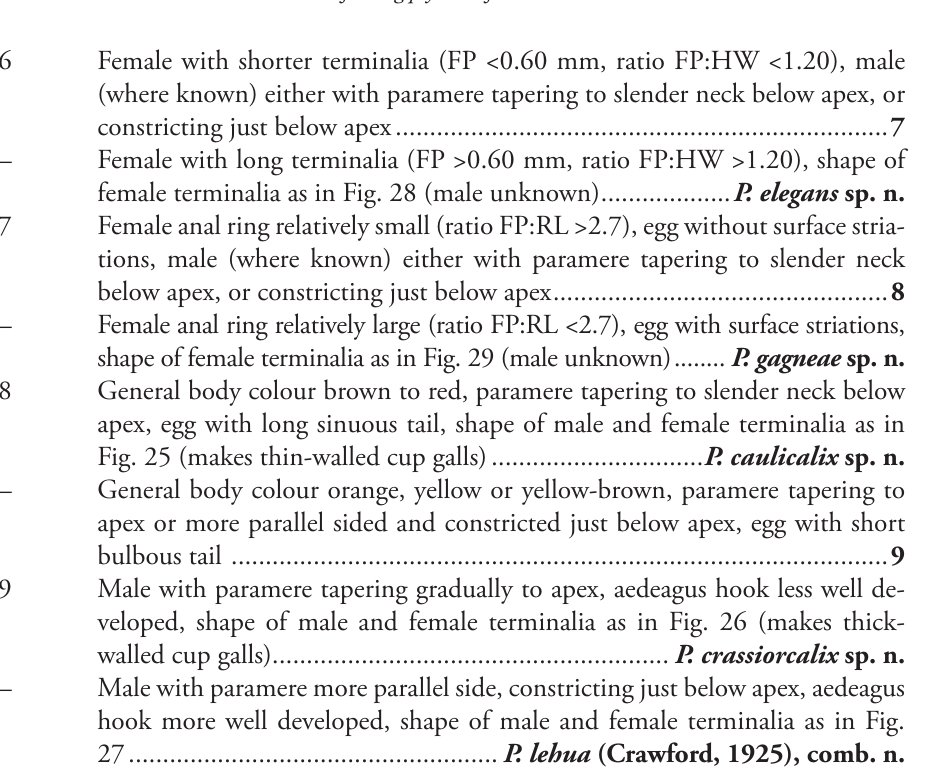
Female with shorter terminalia (FP <0.60 mm, ratio FP:HW <1.20), male (where known) either with paramere tapering to slender neck below apex, or constricting just below apex ........................................................................ 7 – Female with long terminalia (FP >0.60 mm, ratio FP:HW >1.20), shape of female terminalia as in Fig. 28 (male unknown) ................... P. elegans sp. n. 7 Female anal ring relatively small (ratio FP:RL >2.7), egg without surface stria- tions, male (where known) either with paramere tapering to slender neck below apex, or constricting just below apex ................................................. 8 – Female anal ring relatively large (ratio FP:RL <2.7), egg with surface striations, shape of female terminalia as in Fig. 29 (male unknown) ........ P. gagneae sp. n. 8 General body colour brown to red, paramere tapering to slender neck below apex, egg with long sinuous tail, shape of male and female terminalia as in Fig. 25 (makes thin-walled cup galls) ............................... P. caulicalix sp. n. – General body colour orange, yellow or yellow-brown, paramere tapering to apex or more parallel sided and constricted just below apex, egg with short bulbous tail ................................................................................................ 9 9 Male with paramere tapering gradually to apex, aedeagus hook less well de- veloped, shape of male and female terminalia as in Fig. 26 (makes thick- walled cup galls) .......................................................... P. crassiorcalix sp. n. – Male with paramere more parallel side, constricting just below apex, aedeagus hook more well developed, shape of male and female terminalia as in Fig. 27 ...................................................... P. lehua (Crawford, 1925), comb. n.